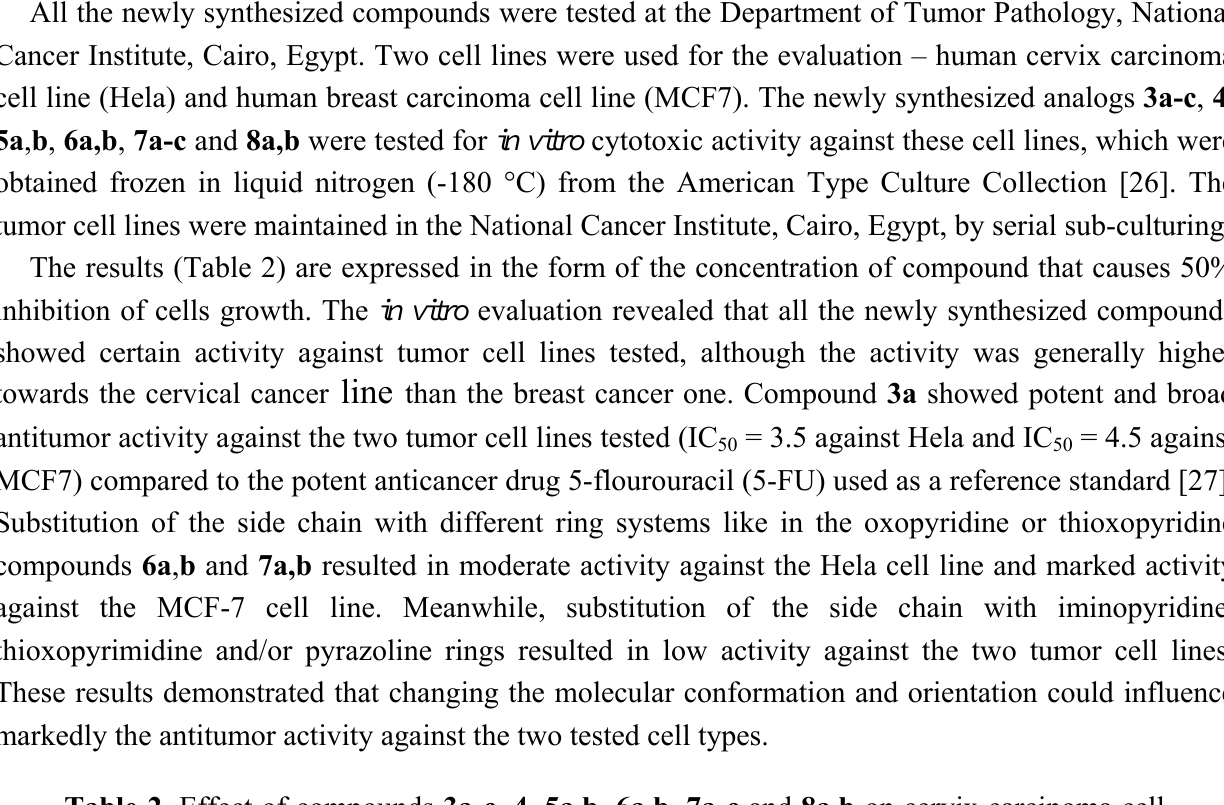
Table 2. Effect of compounds 3a-c , 4 , 5a , b , 6a,b , 7a-c and 8a,b on cervix carcinoma cell line (Hela) and breast carcinoma cell line